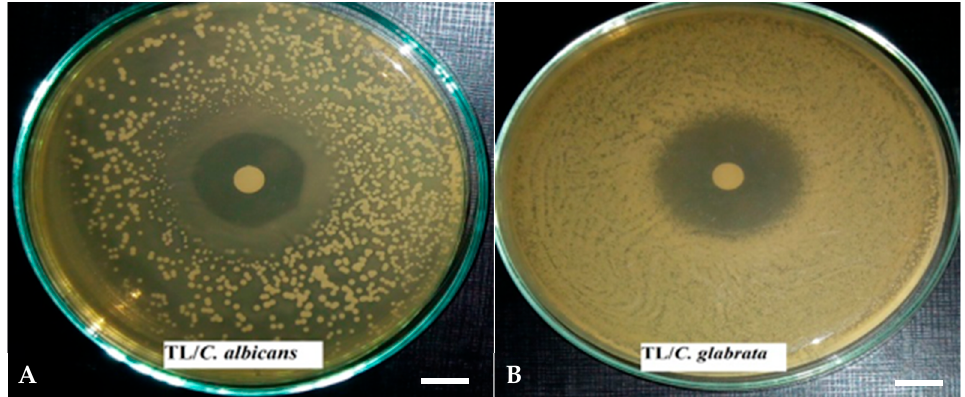
Figure 1. Examples of the antimicrobial activity of plant essential oils by the disc diffusion method. ( A ) Effect of Thymus leptobotrys on Candida albicans . ( B ) Effect of Thymus leptobotrys on Candida glabrata . Bars correspond to 1 cm.